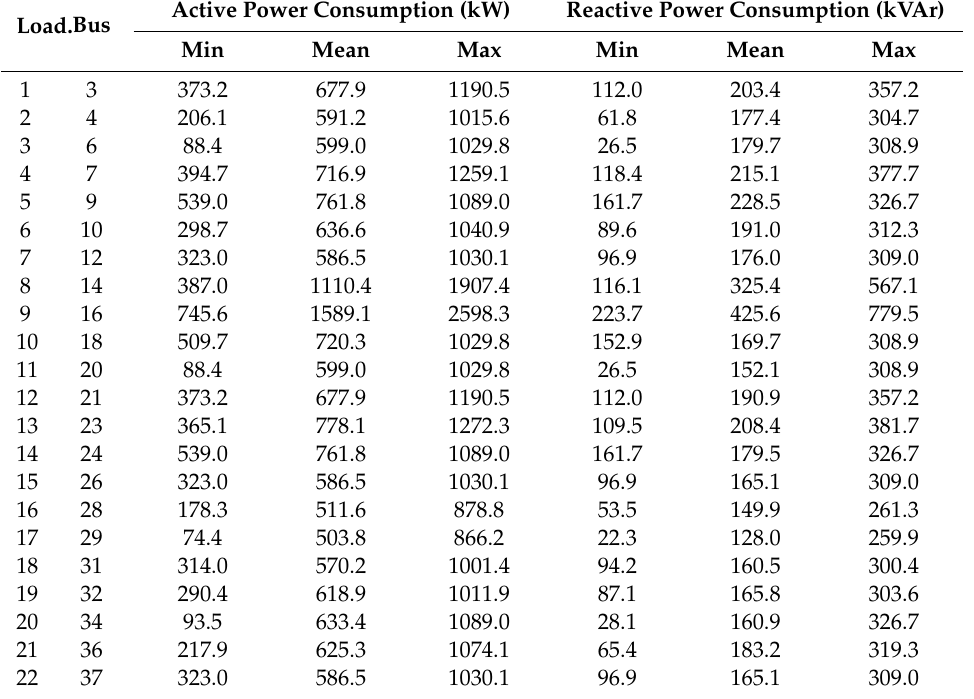
Table 2. Active and reactive power consumption characteristics.